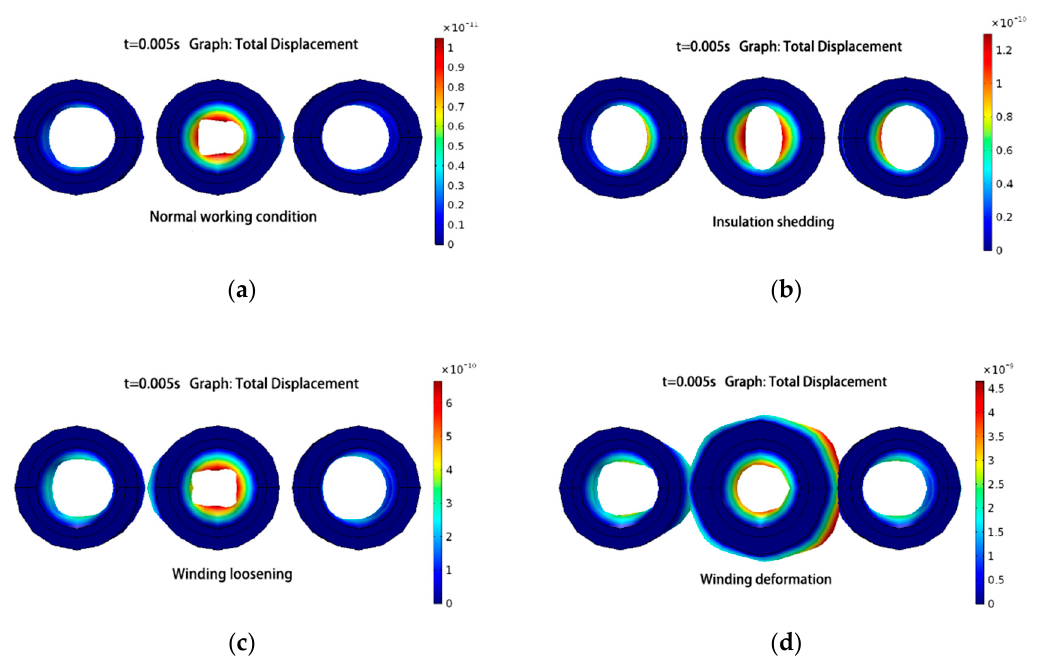
Figure 15. Amplitude direction diagram of winding force displacement under various conditions. ( a ) Normal working; ( b ) Insulation Shedding; ( c ) Winding loosening and ( d ) Winding deformation.